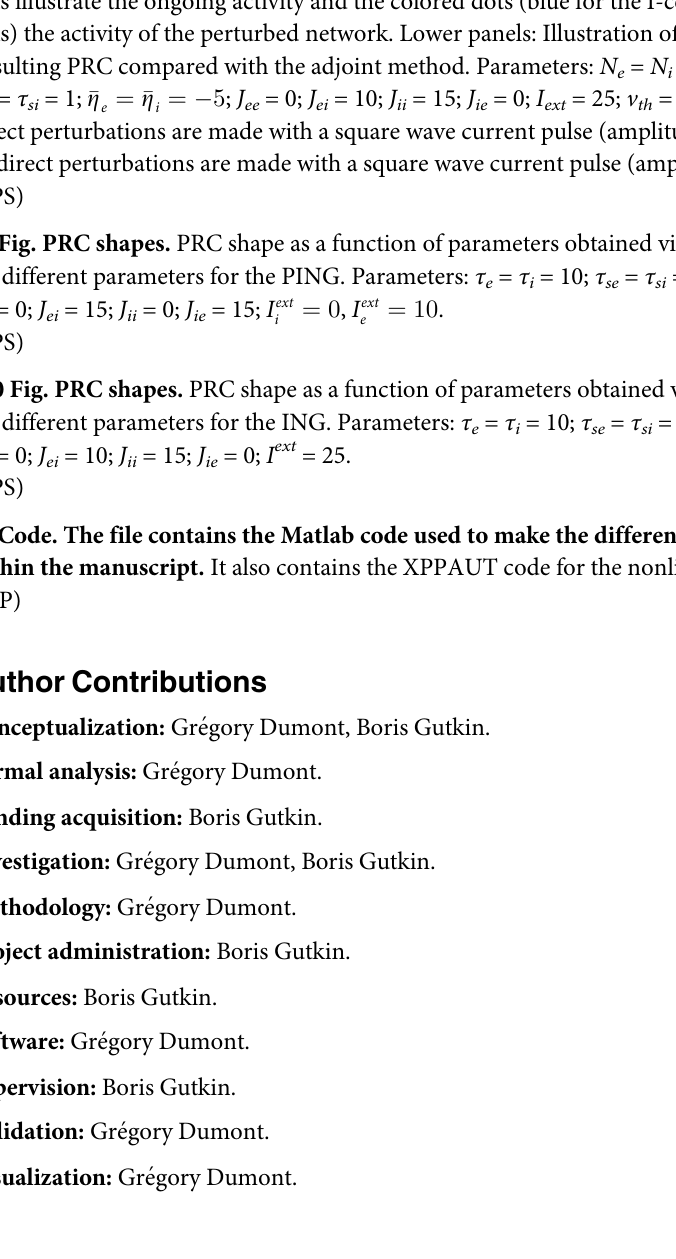
S8 Fig. Phase shifting with perturbation on the E-cells for ING. A) Spiking activity obtained from simulations of the full spiking network and illustration of the stimulus onset. The black dots illustrate the ongoing activity and the colored dots (blue for the I-cells and red for the E- cells) the activity of the perturbed network. Lower panels: Illustration of the stimulus onset. B) Resulting PRC compared with the adjoint method. Parameters: N